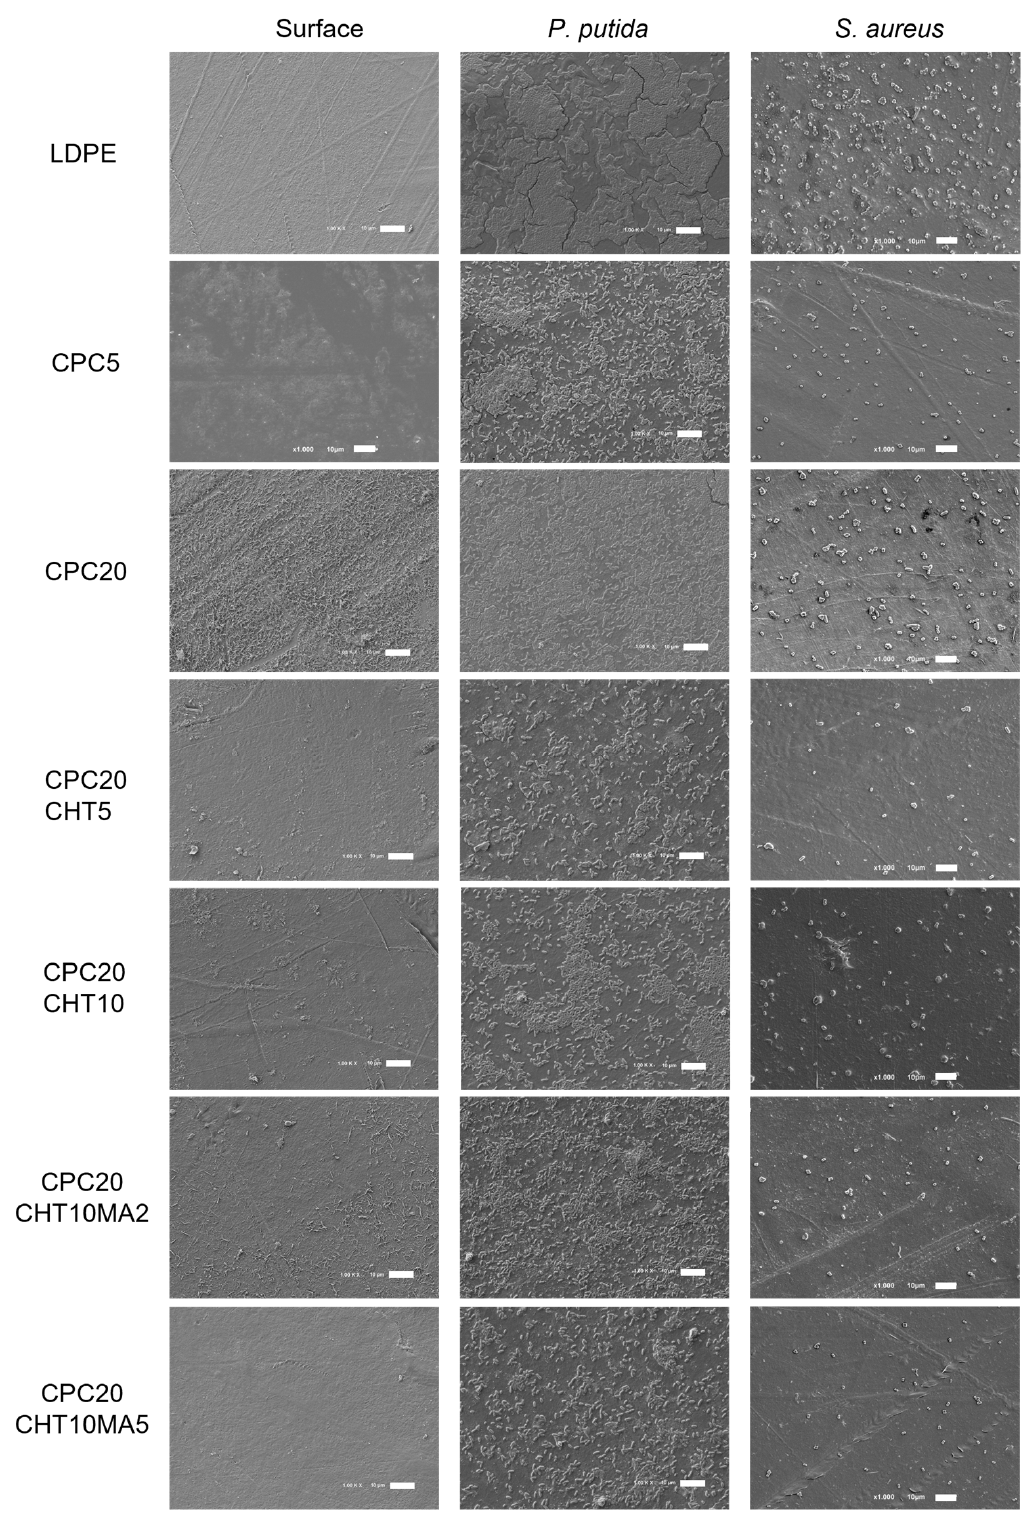
Figure 8. SEM images of neat LDPE and biocomposites (left column), and of P. putida (middle column) and S. aureus biofilms (right column) formed after 3 days of incubation. The scale bar represents 10 µm, magnification of ×1000.